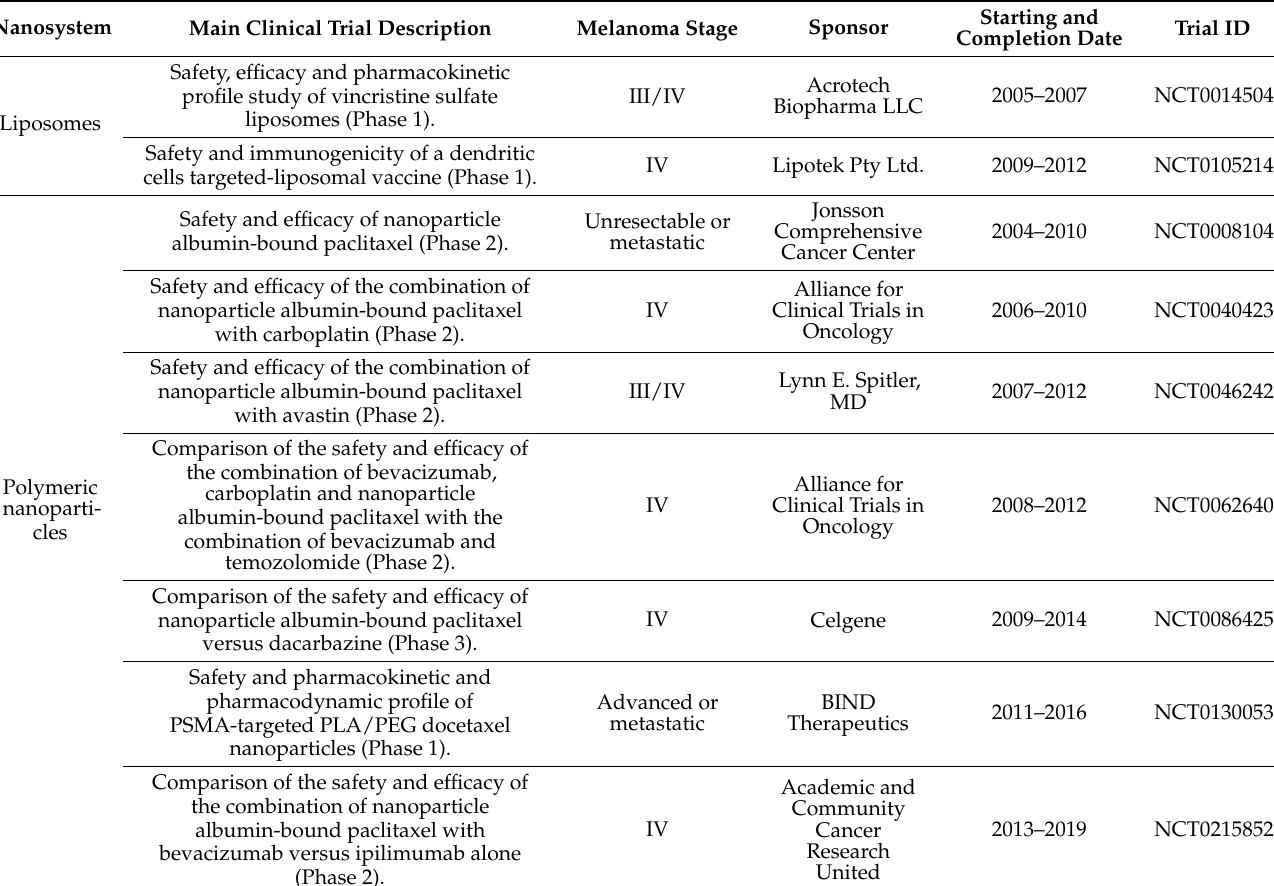
Table 5. Examples of completed clinical trials using different types of nanosystems for melanoma